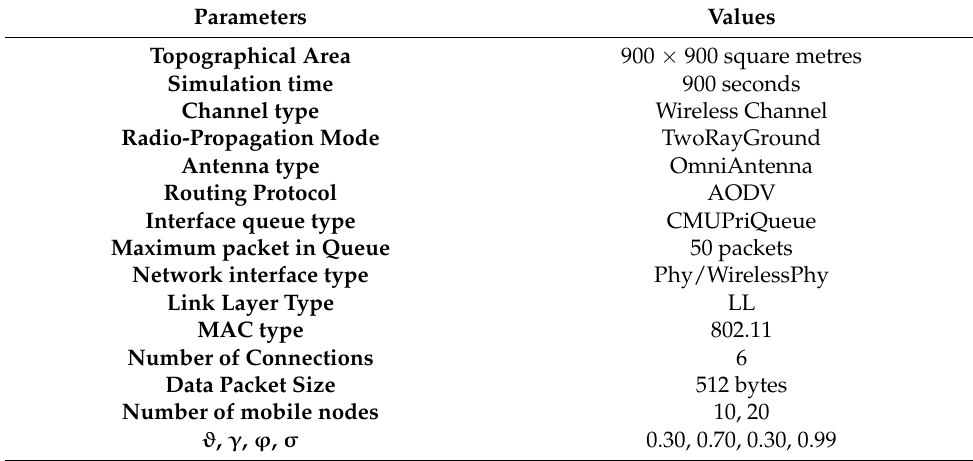
Table 3. Simulation environment and parameters.